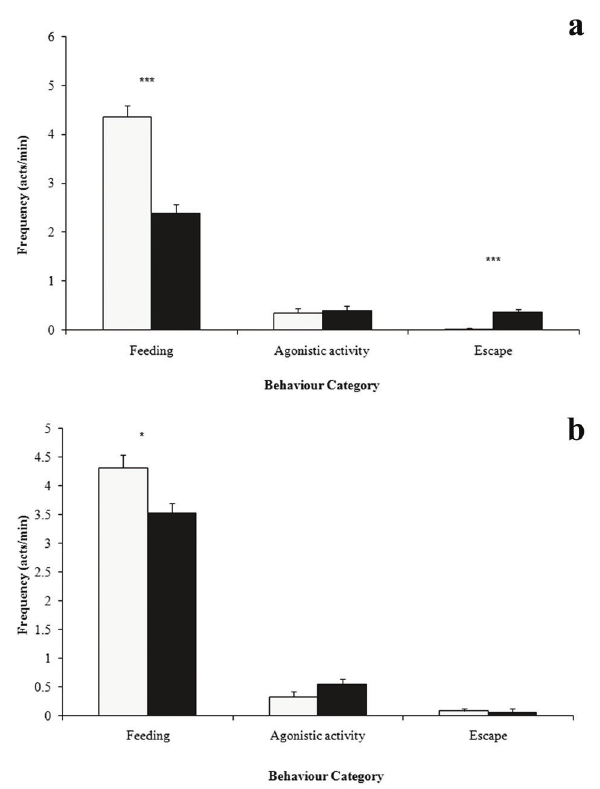
Fig. 8. Variation of behaviour patterns between before (8h00) and after (9h00) the first disturbance of tourists in the river (mean and SEM) for M. bonita ; (a) Tourism and (b) No Tour- ism. Lighter bars = 8h00; darker bars = 9h00 (Mann-Whitney U-test). N = 70; * p < 0.05; ** p <